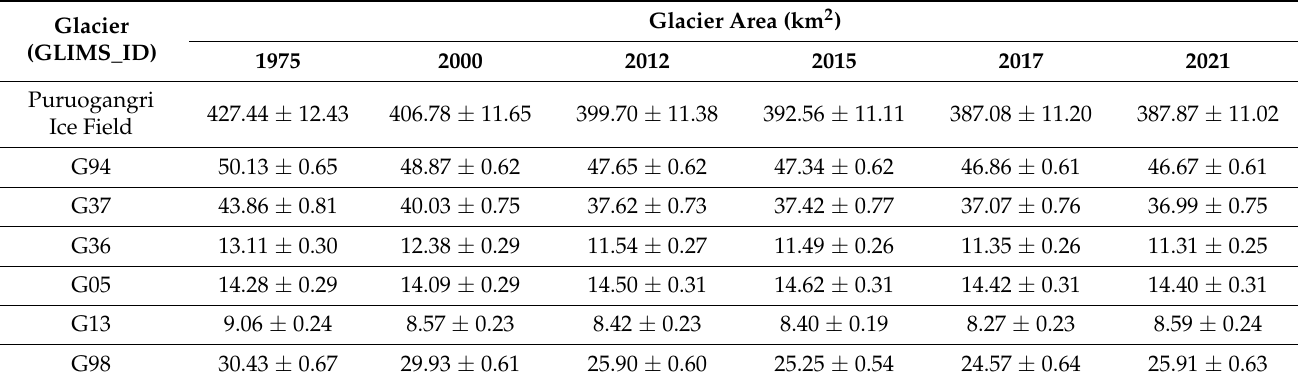
Table 2. The glacier areas in 1975, 2000, 2012, 2015, 2017 and